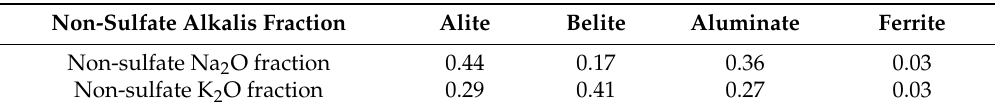
Table 5. Fractional distribution of the total non-sulfate Na 2 O and K 2 O that are assumed to occur in the main clinker phases [8].